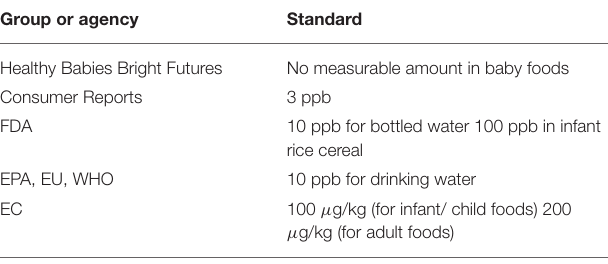
TABLE 2 | Proposed and existing inorganic arsenic standards. Group or agency